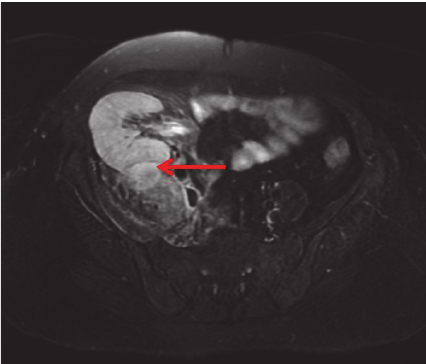
Figure 1: Plain computed tomography. A large uterine tumor (red square) compressed the distal ureter of the transplanted kidney (red arrowhead), causing hydronephrosis (red arrow).